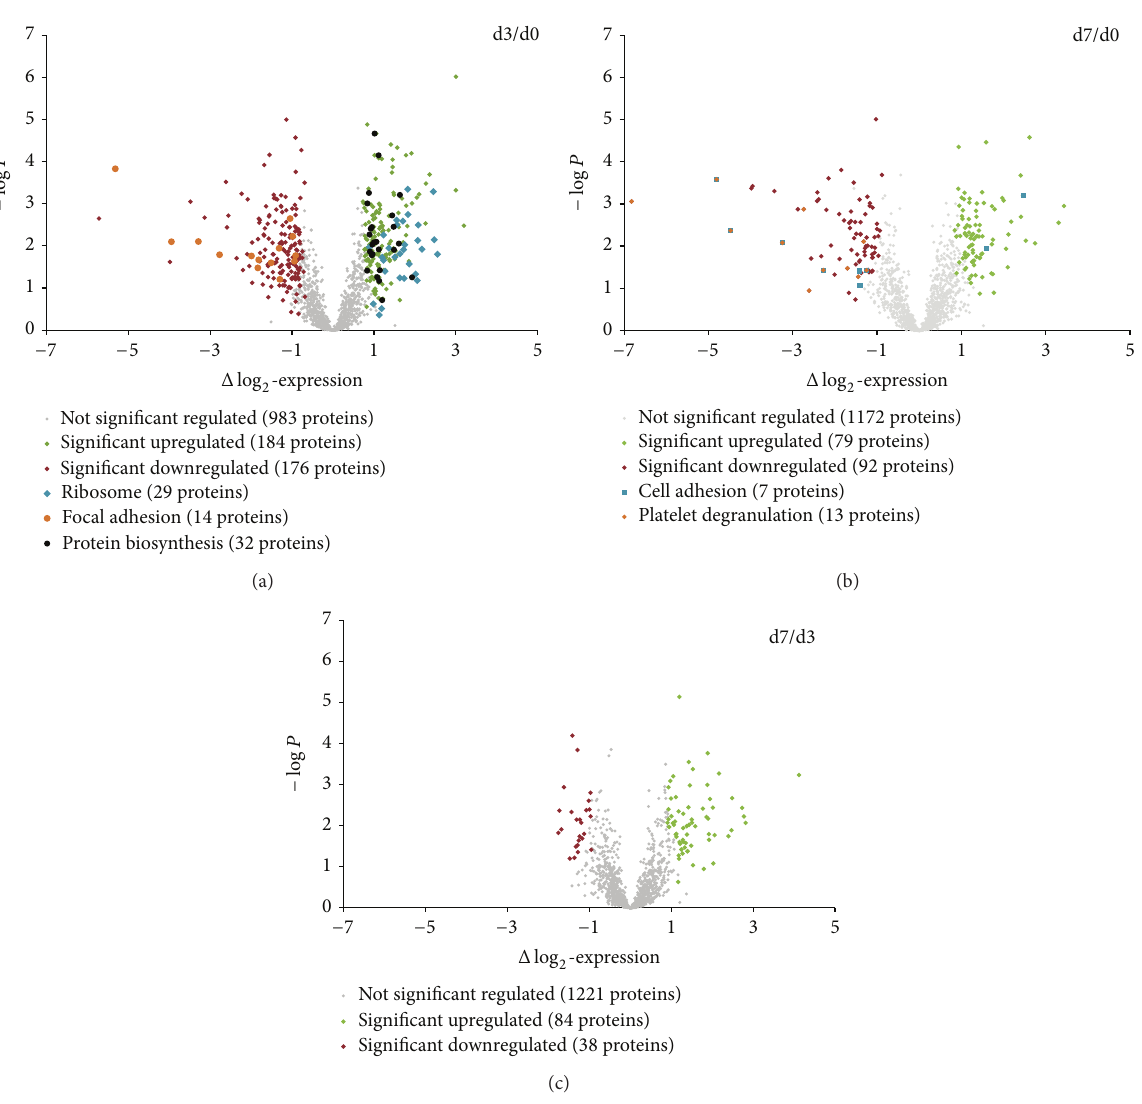
Figure 3: Volcano plot of pairwise differences in protein abundance. Significant regulated proteins must show differences in log 2 -differences in protein abundance ( 𝑥 -axis) and in the –log, 𝑃 value ( 𝑦 -axis). Proteins with biological processes like focal adhesion or protein biosynthesis showed a strong regulation between day 0 and day